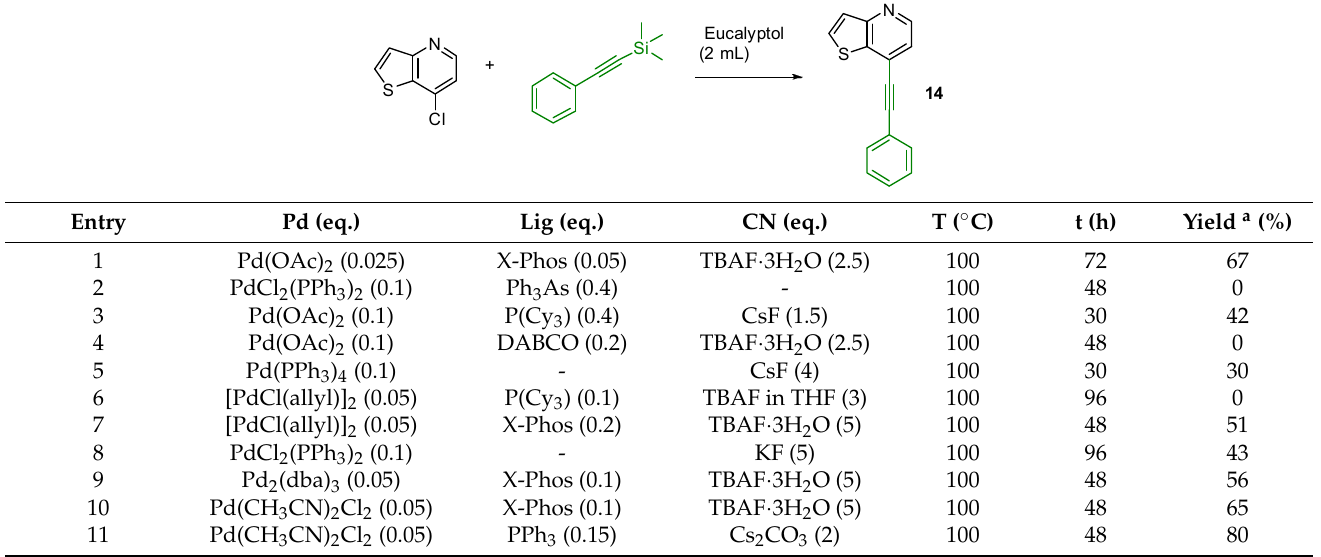
Table 4. Optimization of Hiyama coupling.